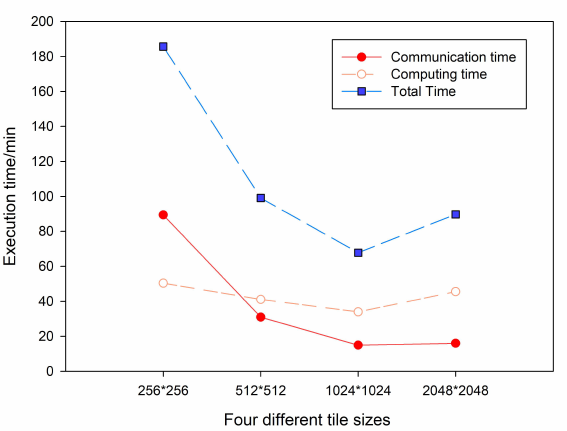
Figure 16. Comparison of the execution times using different tile